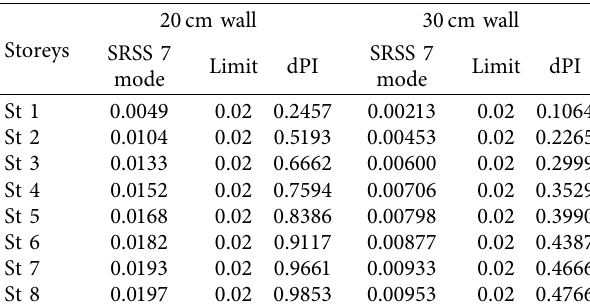
Table 10: dPI calculated for stif/fexible-side walls.